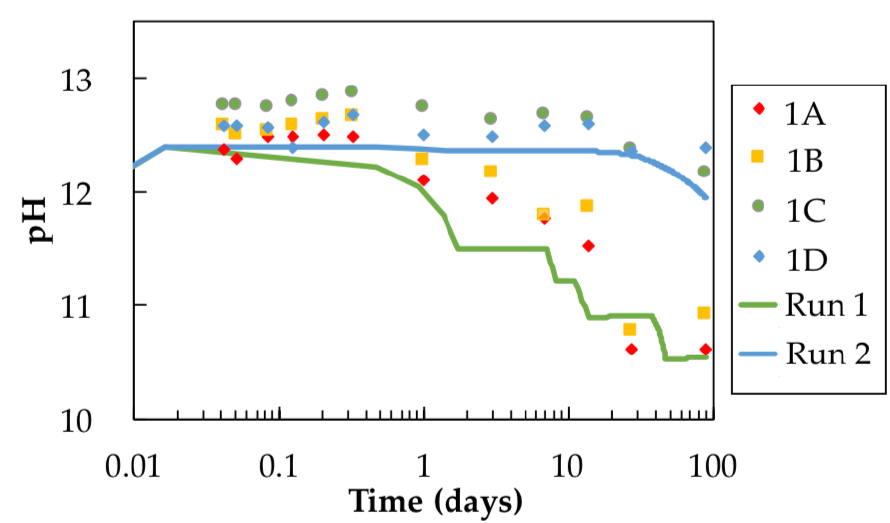
Figure 14. pH changes of the pore water of the simulated mixtures, Run 1 with 16 vol % and Run 2 with 4 vol % of amorphous silica.